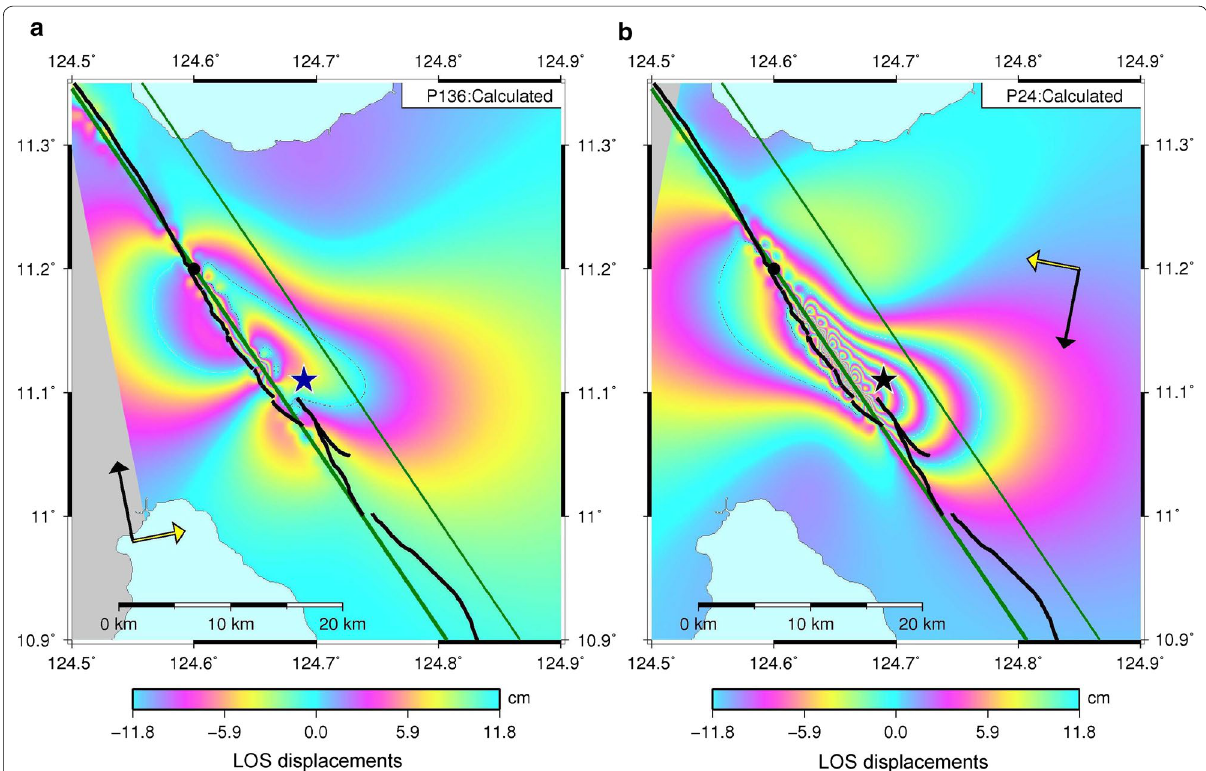
Fig. 13 a Ascending and b descending simulated interferograms corresponding to the estimated fault slip distribution (Fig. 12). Black circle corresponds to the origin (Length 0) in Fig. 12. Thick and thin green lines correspond to the location of the top and bottom sides of the fault = plane, respectively. The small-scale variation of the fringes very close to the fault top is due to imperfectly smooth slip distribution that results